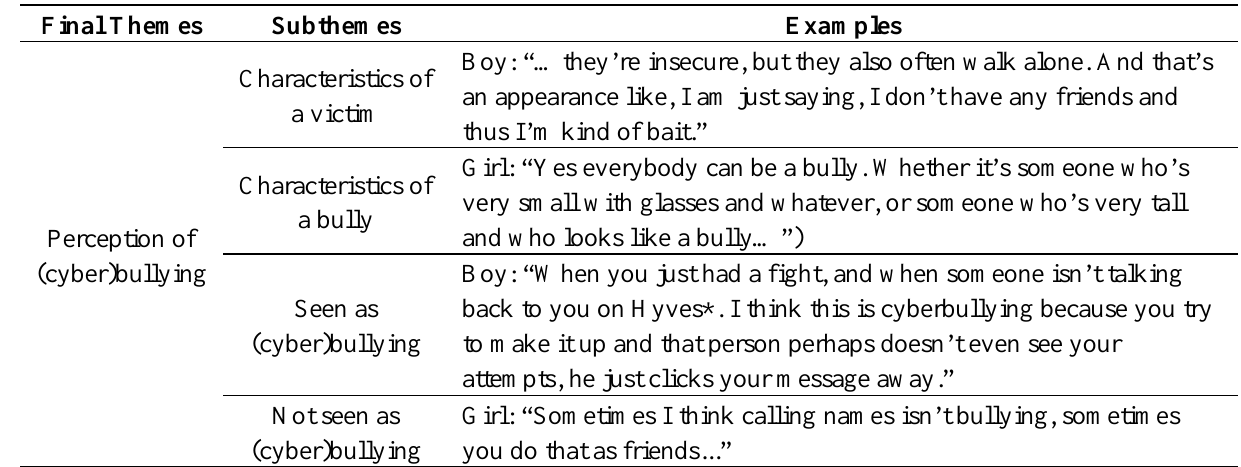
Table 5. Main themes, subthemes and examples for perceptions of (cyber)bullying. Final